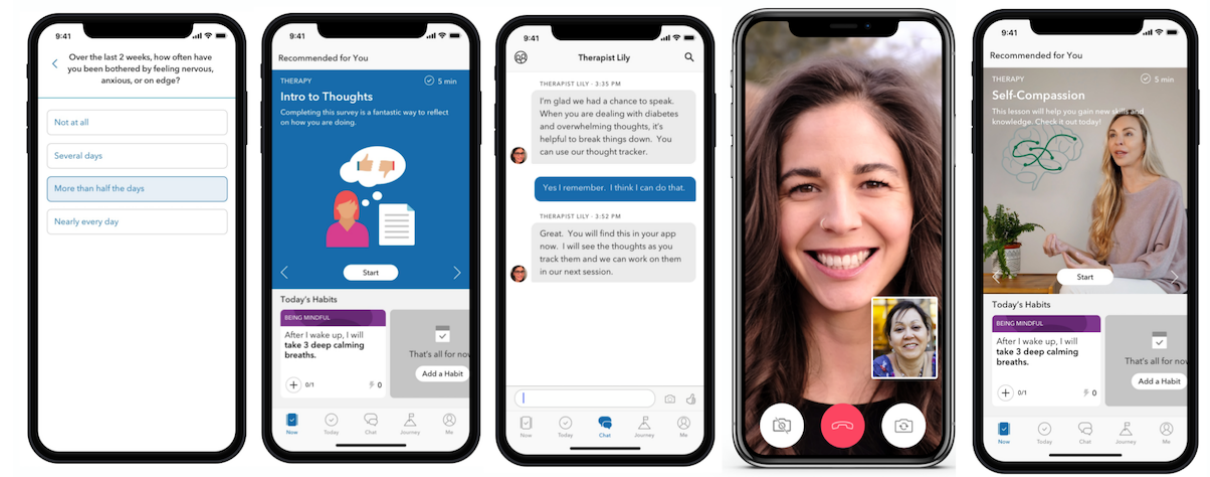
Figure 2. Vida Health Therapy program